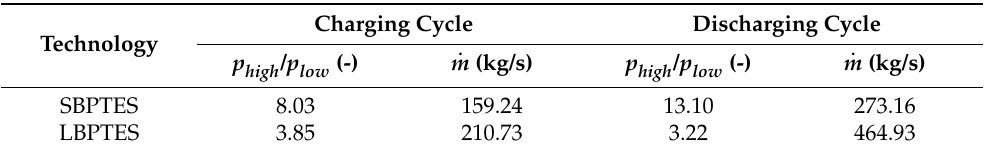
Table 5. Operating conditions of LBPTES and SBPTES systems. The results are related to the nominal power rating of 50 MW and a charging duration of 8 h. Charging Cycle Discharging Cycle Technology p / p high low